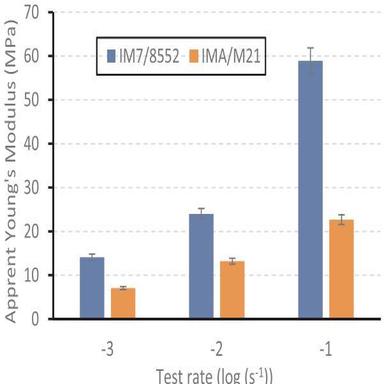
The variation of the apparent Young's modulus with rate. (For interpretation of the references to colour in this figure legend, the reader is referred to the web version of this article.)